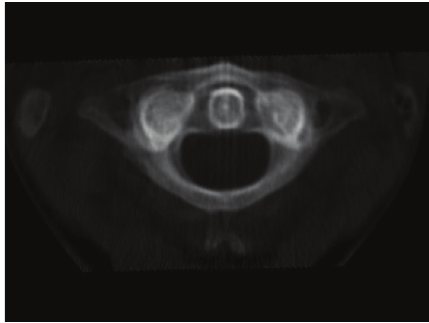
Figure 2: This axial CT scan depicts C1-C2 after reduction, CT-MIP (maximum intensity projection).